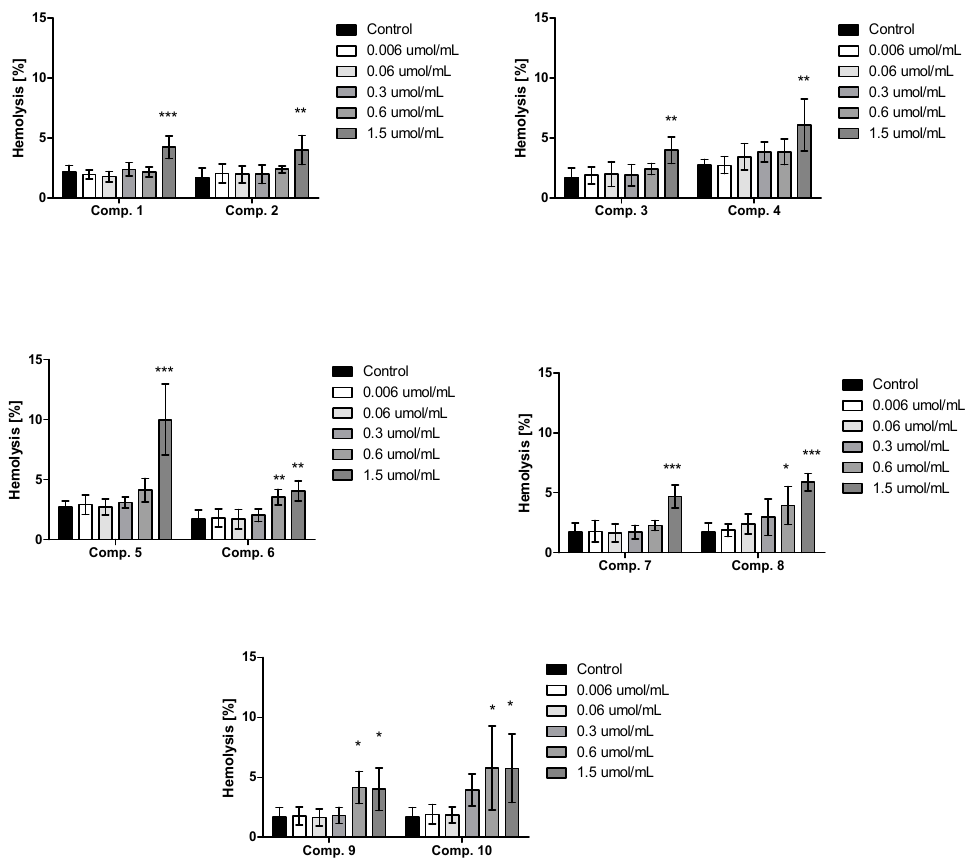
Figure 2. Effects of synthesized compounds 1 – 10 on the hemolysis of erythrocytes. Positive control was Triton X-100, which constituted 100% hemolysis. The results are presented as mean ± S.D.; n = 4, * denotes significant differences compared to control (* p < 0.05; ** p < 0.01; *** p < 0.001). Exposure to all compounds at 1.5 µmol/mL contributed to a significant increase in erythrocyte hemolysis; however, in most cases this value did not exceed 5%. In our previous study [22], metformin was not found to significantly affect RBC (red blood cell) hemolysis.